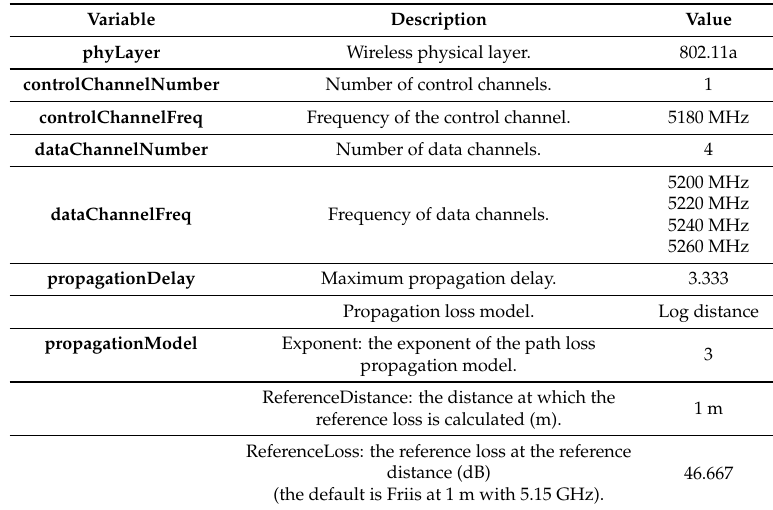
Table 7. Physical layer